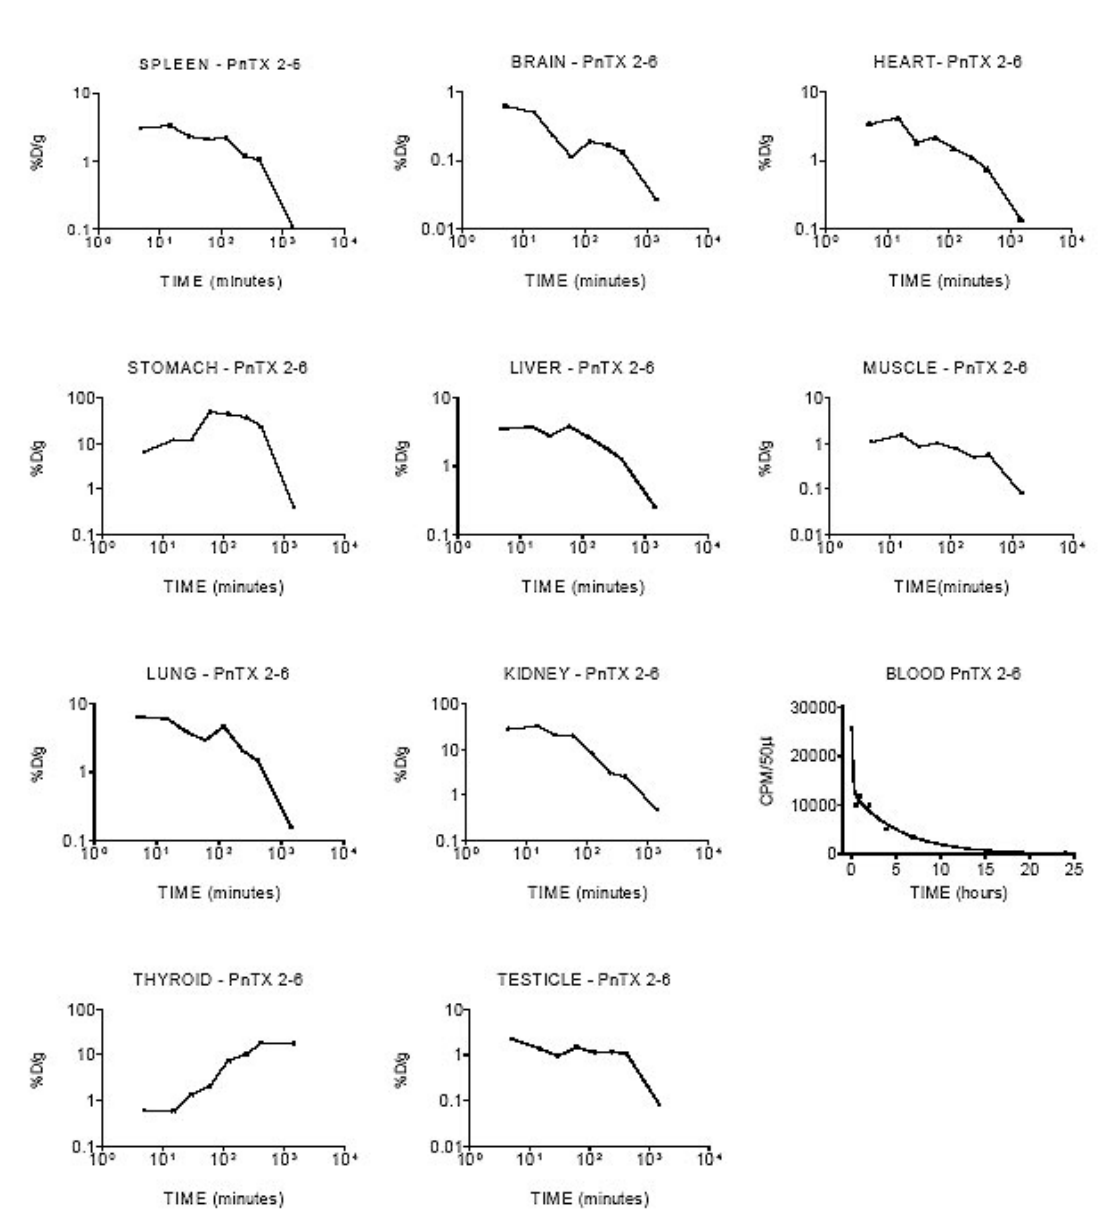
Figure 1. 125 I-PnTX2-6 toxin kinetic behaviour in different organs over 24 hours after intravenous administration. Data were expressed as the percentage of total dose (%D) injected per tissue weight (g) or 50 µ L of blood sample versus